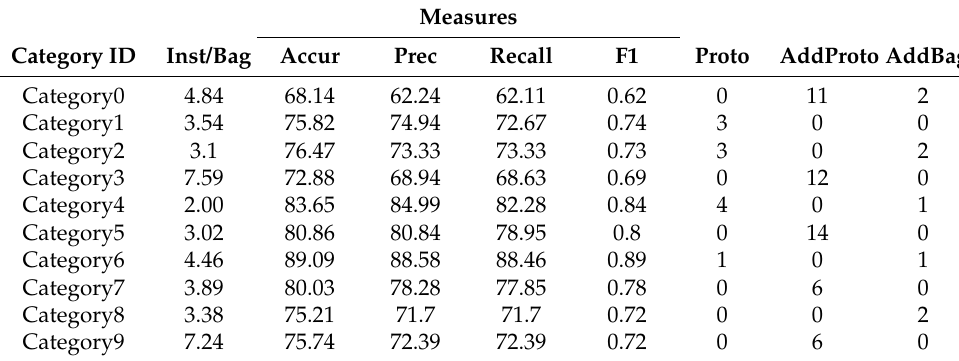
Table 6. Classification results using MILTree-SI on the Corel